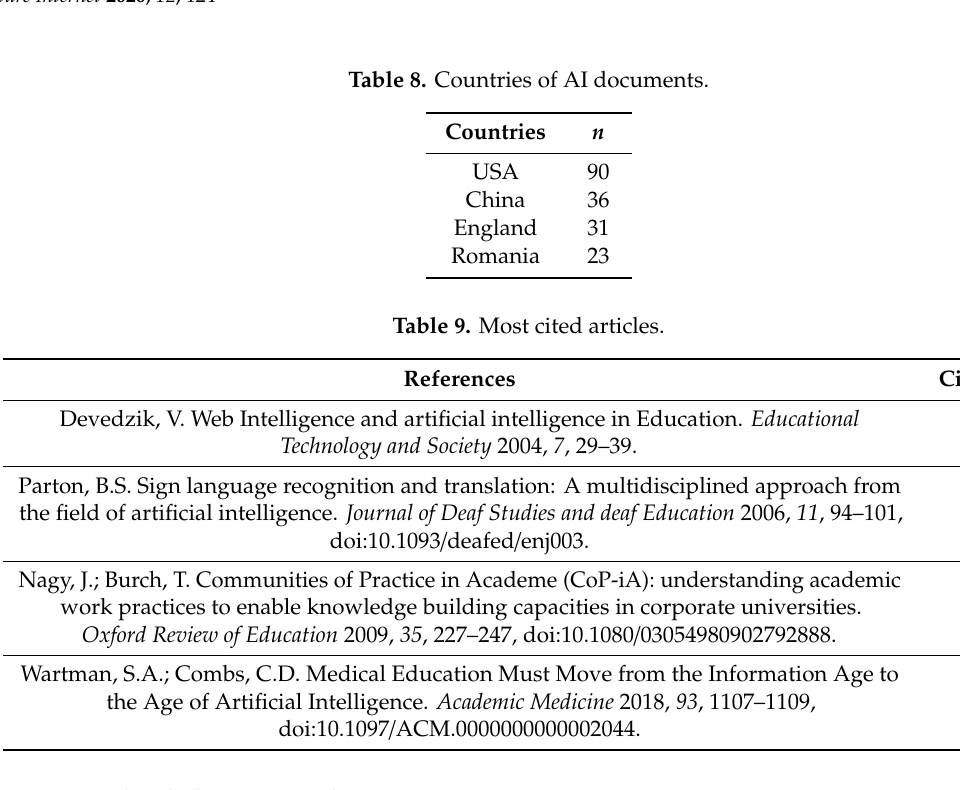
Table 8. Countries of AI documents.